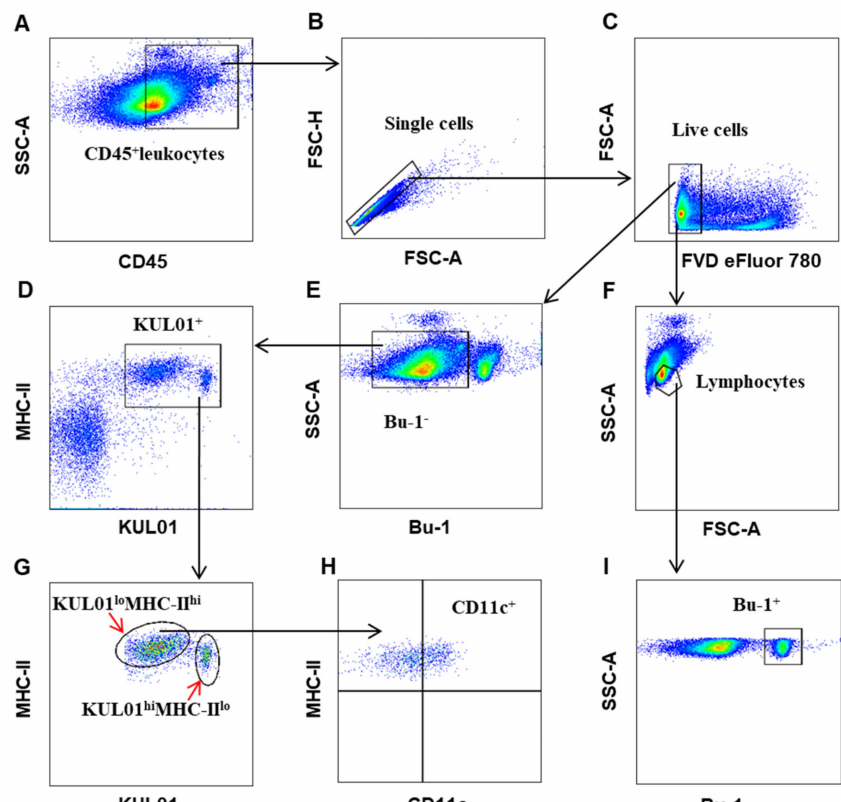
Figure 1. Gating strategies to identify chicken B-cells and myeloid lineage. Mononuclear cells were isolated from spleens of 4 weeks-old naïve chicken and surface stained with antibody cocktails (panel 1: CD45, Bu-1, KUL01, MHC-II, CD11c, and FVD eFluor 780). The leukocytes were gated with CD45 positive ( A ) and then single cells were gated based on size and granularity using FSC-A and FSC-H ( B ). Live cells were defined as FVD eFluor 780-negative ( C ). Then, the lymphocytes were chosen ( F ) using forward scatter (FSC)-A and SSC-A, and Bu-1 + B cells were defined ( I ). By excluding Bu-1 + B cell ( E ) and outputting KUL01 vs MHC-II, the KUL01 + cells were identified ( D ), which were further subdivided into KUL01 lo MHC-II hi and KUL01 hi MHC-II lo cells ( G ). Finally, partial CD11c expression was confirmed on the KUL01 lo MHC-II hi cells but not on the KUL01 hi MHC-II lo cells ( H